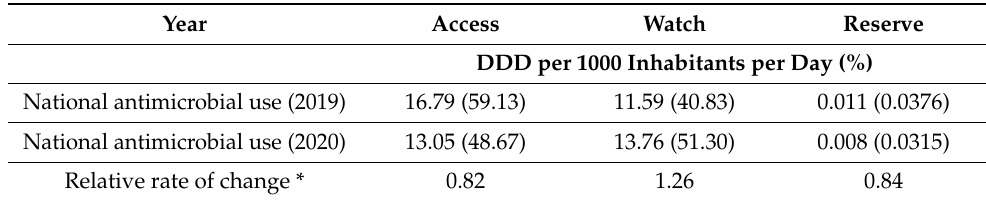
Table 2. Percentage of total national antimicrobial consumption (DDDs) by WHO AWaRe category (Access/Watch/Reserve) for Jordan 2019 and